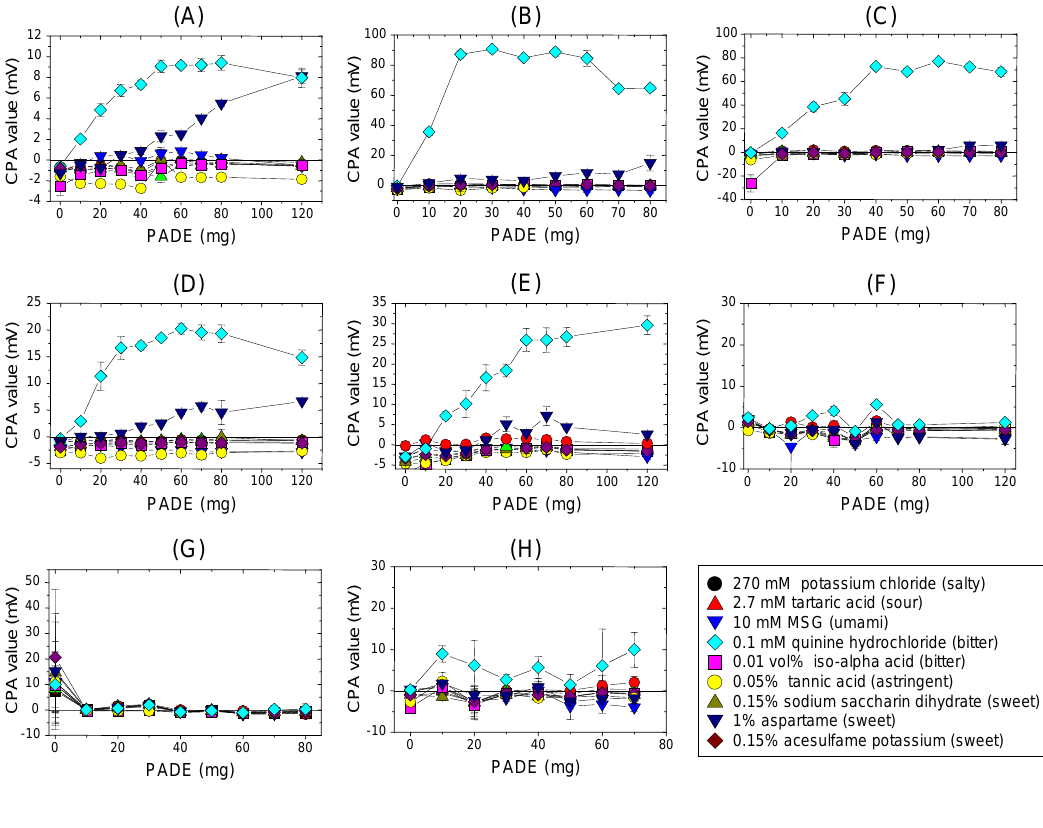
Figure 9. Sensor responses to basic taste substances. The x-axis represents PADE contents in the membrane, while the y-axis shows the CPA value. Data are expressed as mean ±SD (n = 4). All samples include 30 mM KCl and 0.3 mM tartaric acid as supporting electrolyte. Lipid: PADE (phosphoric acid di- n -decyl ester); Plasticizer: A, DOPP; B, BBPA; C, BEHS; D, PTEH; E, TBAC; F, TMSPM; G, DGDE; H, TOTM (Reprinted with permission from the Institute of Electrical Engineers of Japan